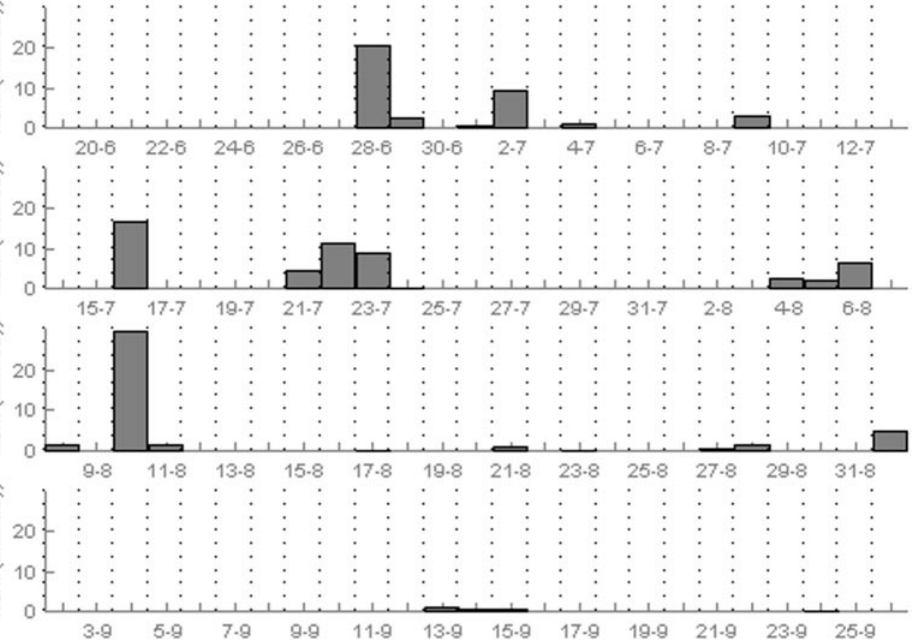
Fig. 4. Rainfall during the 1997 WELSONS experiment. It did not rain during the month before the beginning of the experiment on 19 June. Thus di(cid:128)erent states of soil humidity were encoun- tered (wet soil, dry soil, very dry soil with